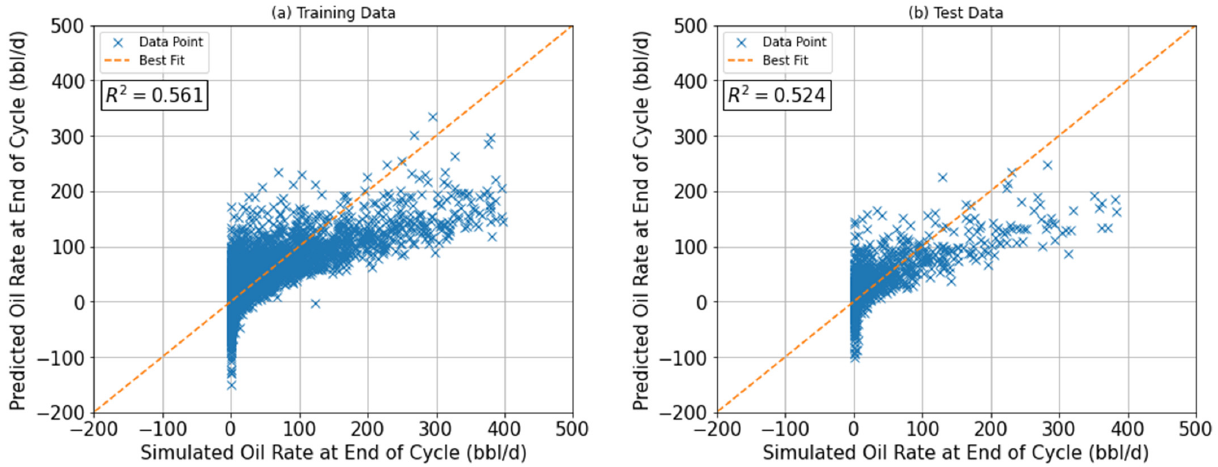
Figure 9. Predicted and simulated plot of ( a ) training data and ( b ) testing data for oil rate at the end of the cycle—polynomial regression